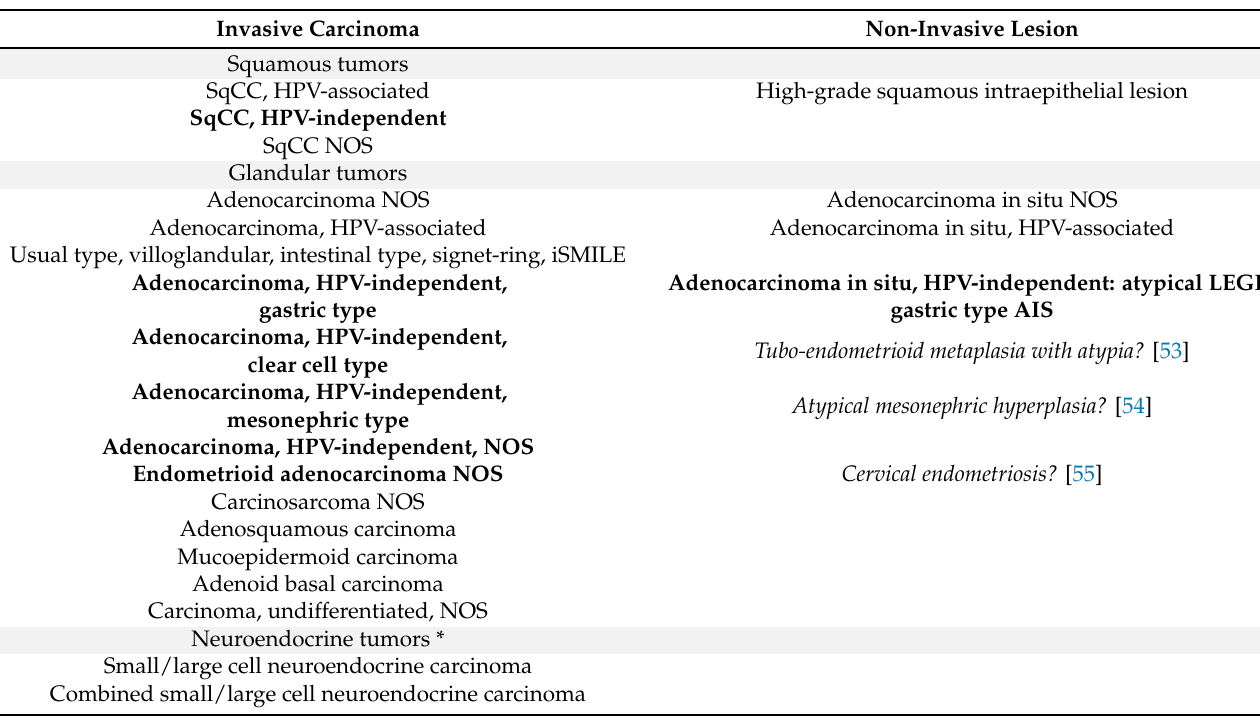
Table 3. 2020 WHO classification of cervical cancers and suggested non-invasive lesions. Invasive Carcinoma Non-Invasive